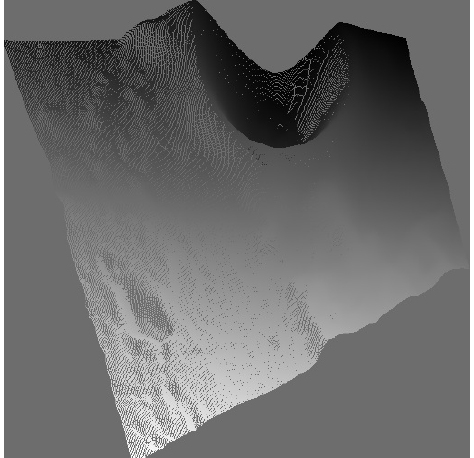
Figure 1: This irregular shadow map was used to produce the shadows in Figure 3. Every cell of the grid can contain an arbi- trary number of light rays. Exactly one light ray corresponds to a camera pixel and only this ray is used for the shadow calculation of the pixel. This results in shadows without aliasing. mesh between the sun and the observed intersection point. For